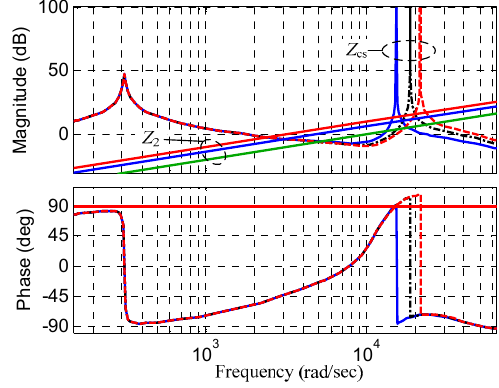
Figure 8. Bode diagrams of Z cs and Z 2.